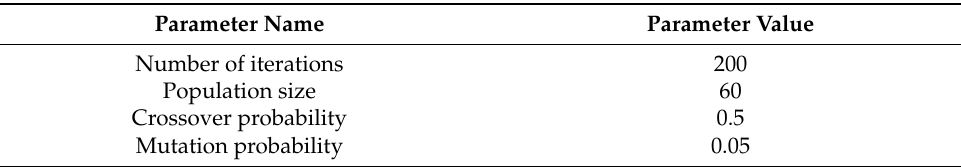
Table 4. GA-BP neural network model parameters.